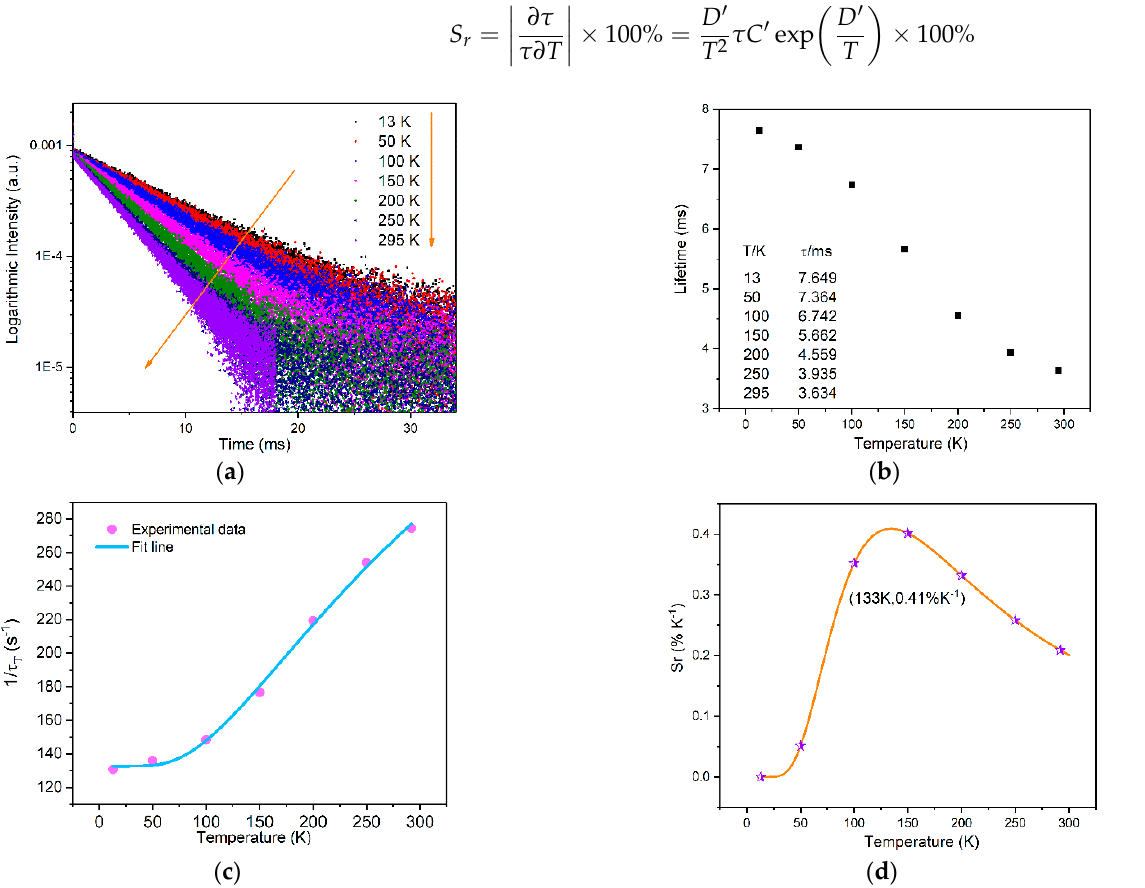
Figure 9. ( a ) Temperature-dependent decay curves in the temperature range from 13 to 295 K; ( b ) calculated lifetime values; ( c ) lifetime values as a relation with temperature and the fitting line; ( d ) calculated relative sensitivities.